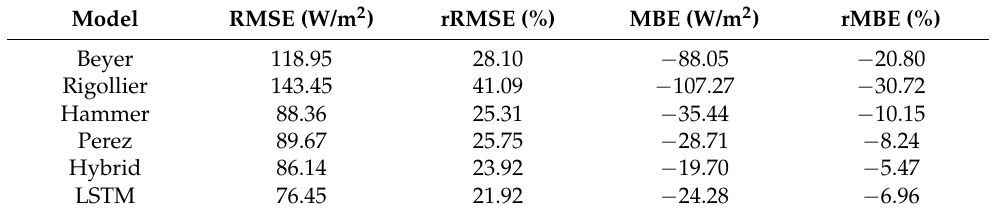
Table 7. Accuracy of the semi-empirical models and LSTM model from October to December